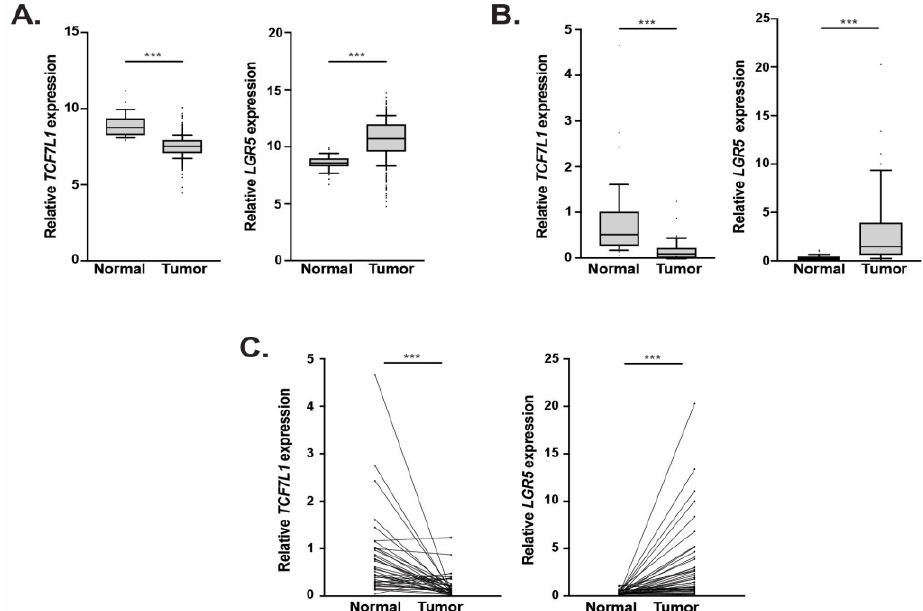
Figure 1. TCF7L1 expression is downregulated and LGR5 expression is upregulated in patient tumor samples. ( A ) Relative TCF7L1 and LGR5 transcript levels in normal colons and tumor patient samples within TCGA COAD database. ( B ) Relative TCF7L1 and LGR5 transcript levels in normal and tumor patient-matched samples obtained from the Carlino Family Inflammatory Bowel and Colorectal Disease biobank at the Pennsylvania State University College of Medicine. Values are normalized to GAPDH. ( C ) Pair-wise analysis of TCF7L1 and LGR5 transcript levels in samples described in ( B ). In ( A , B ), whiskers demarcate the 10–90 percentile range (*** p <